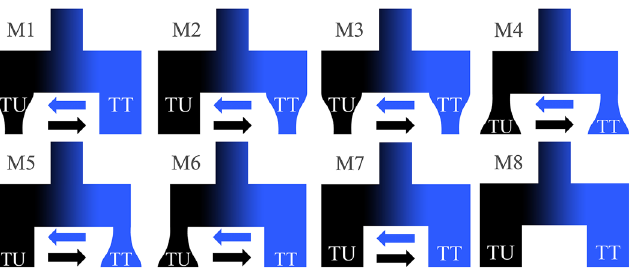
Figure 4. Representations of each two-population model tested with fastsimcoal2 , where TU represents the mainstem population, TT represents the tributaries population, and arrows represent gene flow. Model numbers and parameters correspond to those listed in Table 3.